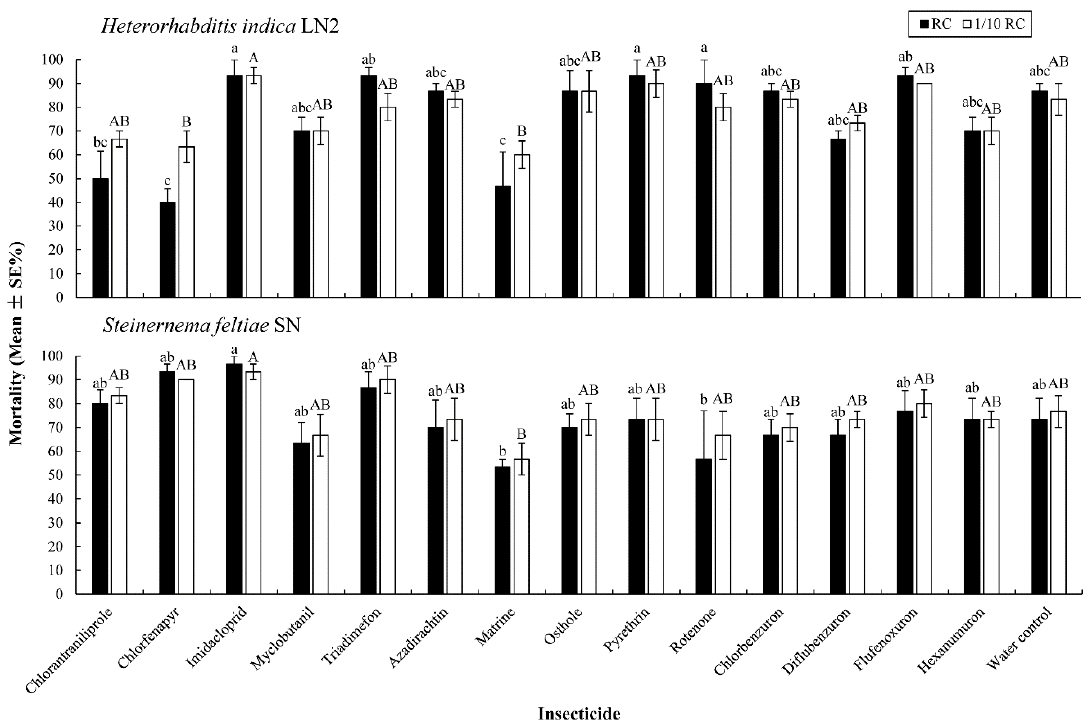
Figure 2. The corrected mortality rates of the Tenebrio molitor larvae, 72 h after exposure to Steinernema feltiae SN and Heterorhabditis indica LN2 in different insecticides, at the recommended field concentration (RC) and 1/10 RC. Bars with different uppercase or lowercase letters indicate significant differences among the different insecticides for RC or 1/10 RC, respectively ( p < 0.05, Tukey’s test).